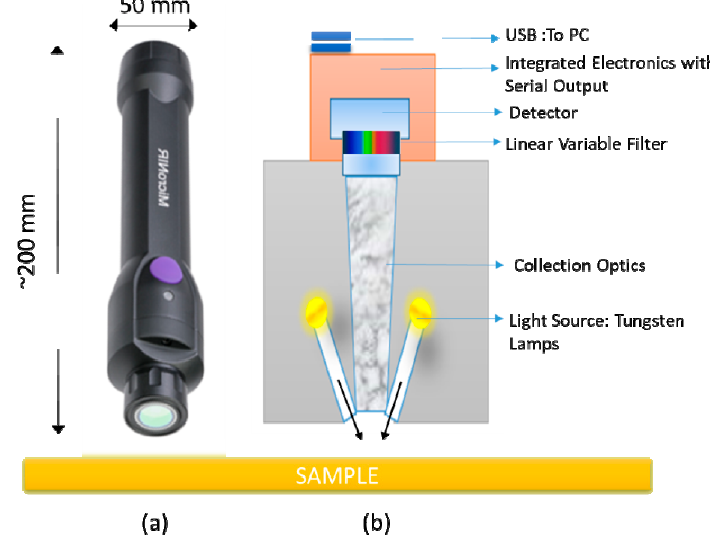
Figure 1. ( a ) Miniaturized near-infrared (microNIR) device and ( b ) instrument operating scheme.